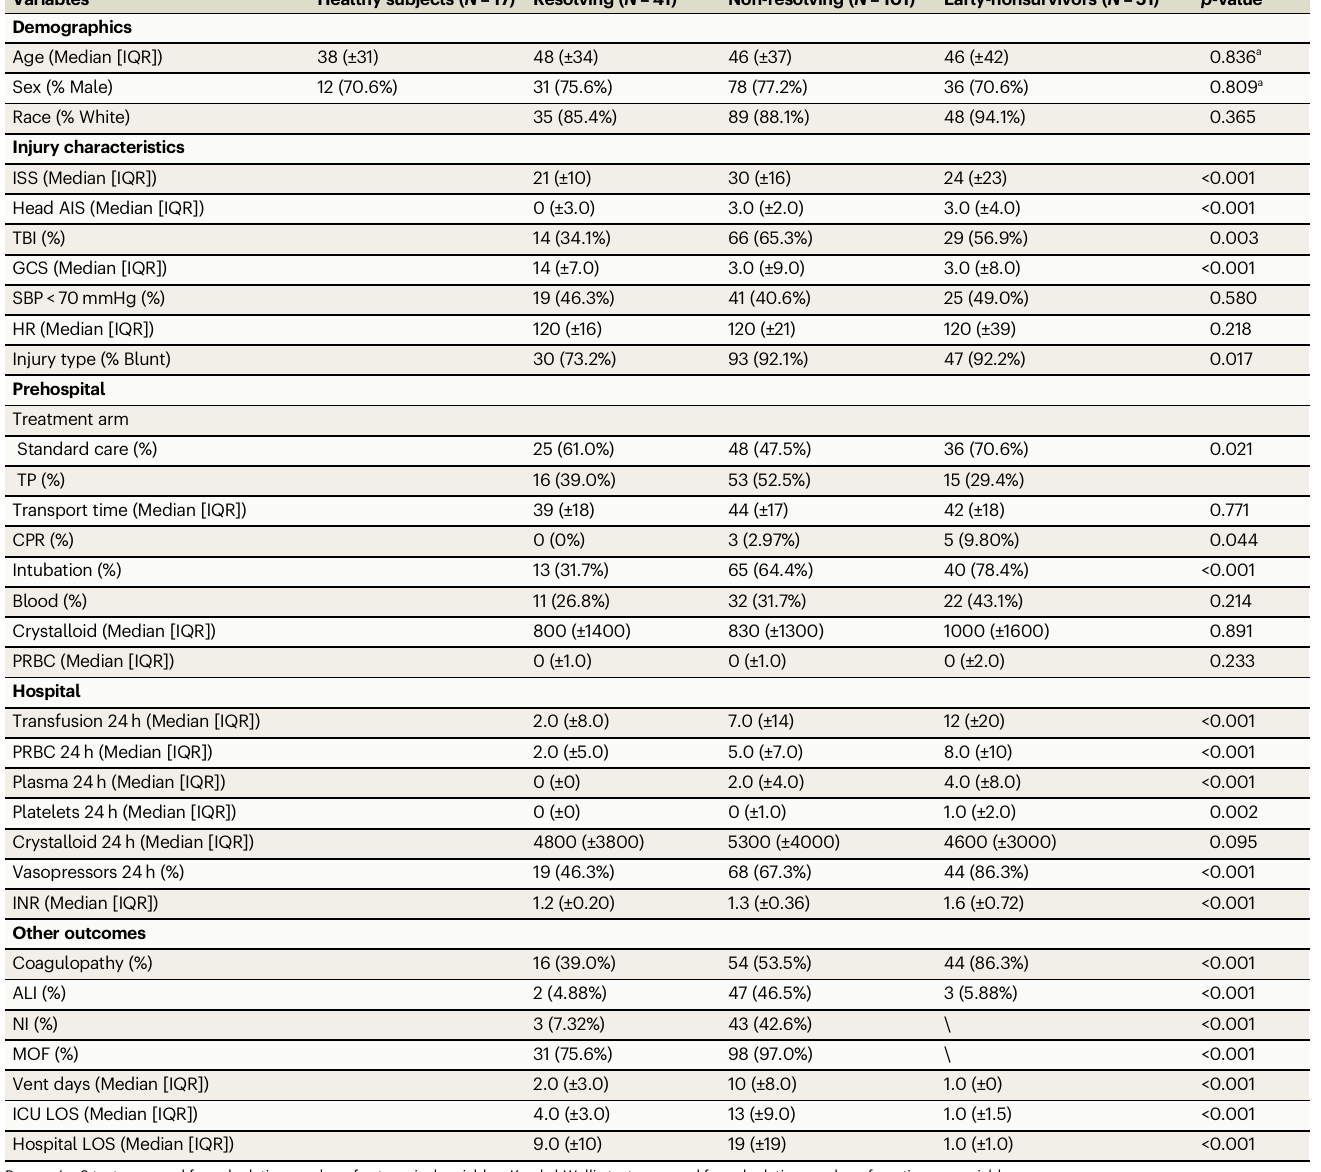
Table 1 | Demographic characteristics of the patients by outcome Variables Healthy subjects ( N =17) Resolving ( N